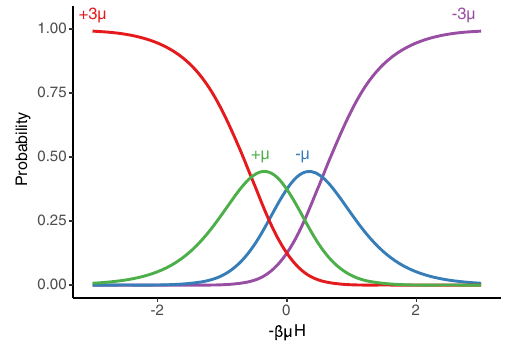
FIG. 3. Probability distributions for the 3-particle spin- 1 = 2 paramagnet as a function of the temperature parameter − β . The horizontal axis has been scaled by μ H to obtain a dimensionless quantity. Because of the negative sign, colder temperatures are on the left and hotter temperatures are on the right. Macrostates are labeled by the net